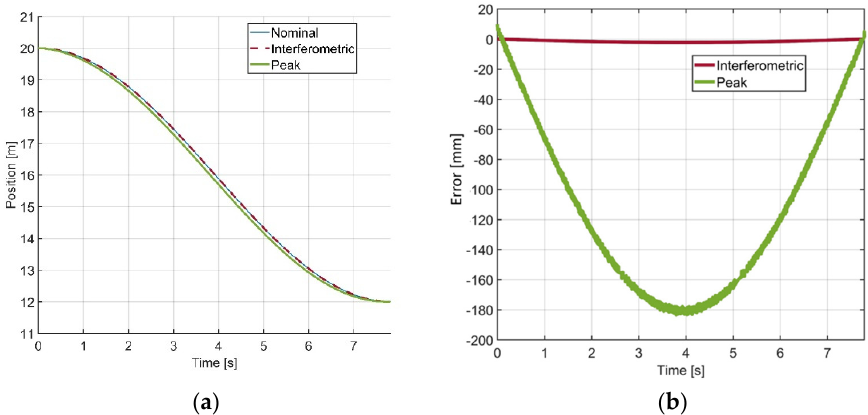
Figure 7. Position retrieved by radar: ( a ) using the interferometric method (green line) and using the peak position (red line); ( b ) error with respect to the nominal position.